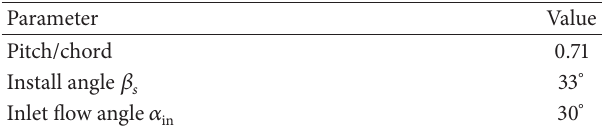
Table 1: Blade parameters.